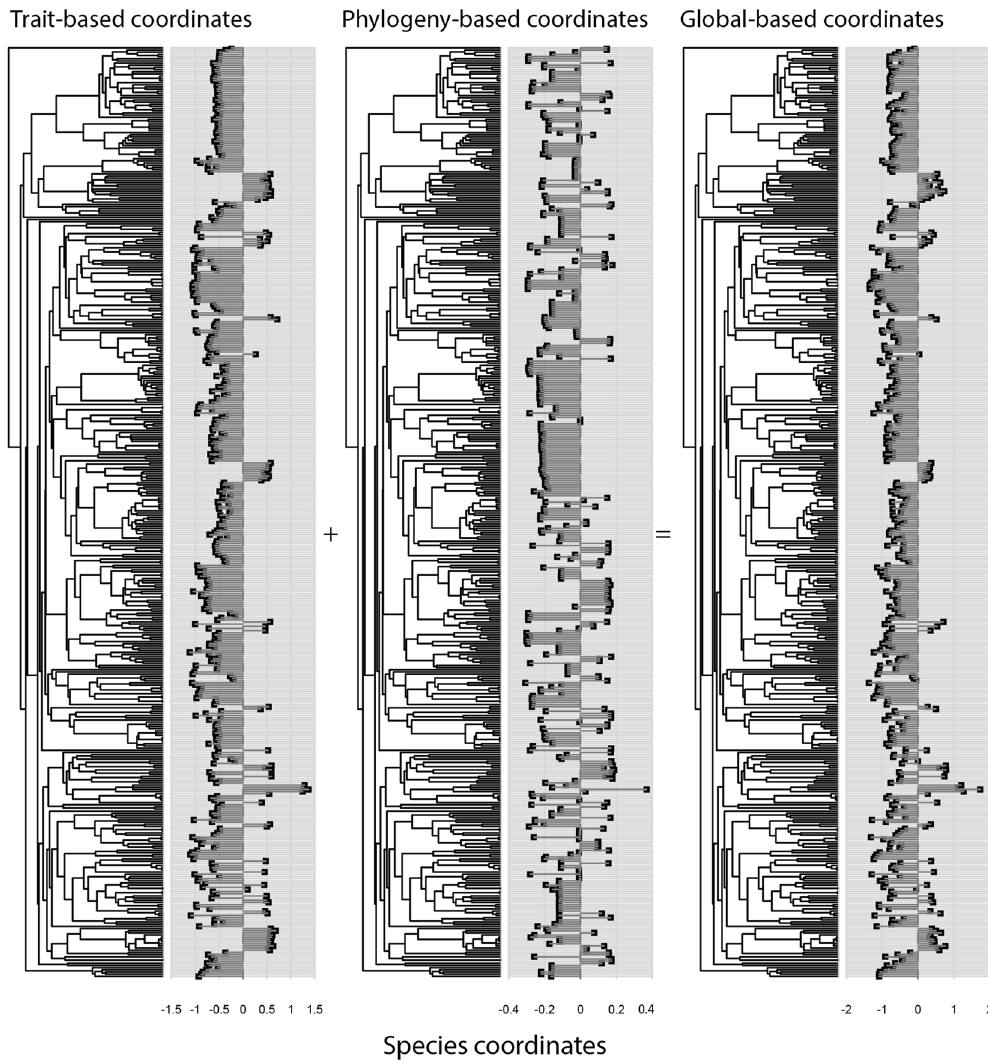
Figure 3. Results of the RLQ analysis visualized on the phylogeny at 20 × 20 m. The coordinates of species are analysed on the first axis only. The global coordinates of the species are defined as the sum of a combination of trait variables and a combination of phylogenetic variables.